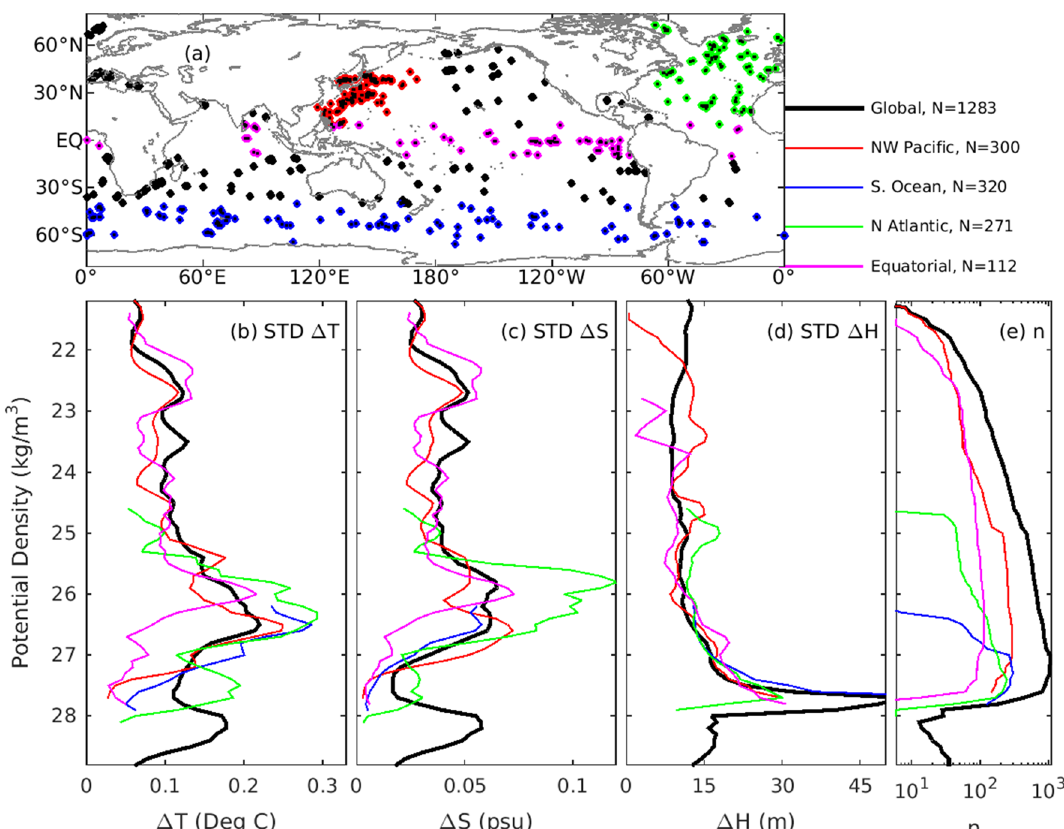
Figure 3. A demonstration of how close analyses should fit in situ observations for a 1/10 ◦ -resolution grid. Analysis of Argo “buddy” floats that sample within 10 km and within 12 h of each other, showing ( a ) the location of each pair; and the standard deviation of the difference of ( b ) temperature ( c ) salinity, and ( d ) isopycnal depths, as a function of potential density; and ( e ) the number of observations, n, in each density range, plotted on a log scale. The colours in each panel are for different regions as denoted in the legend (also showing the number of buddy floats in each region, N). This analysis excludes the top 50 m, where water mass properties are often highly variable and where isopycnal depths are poorly